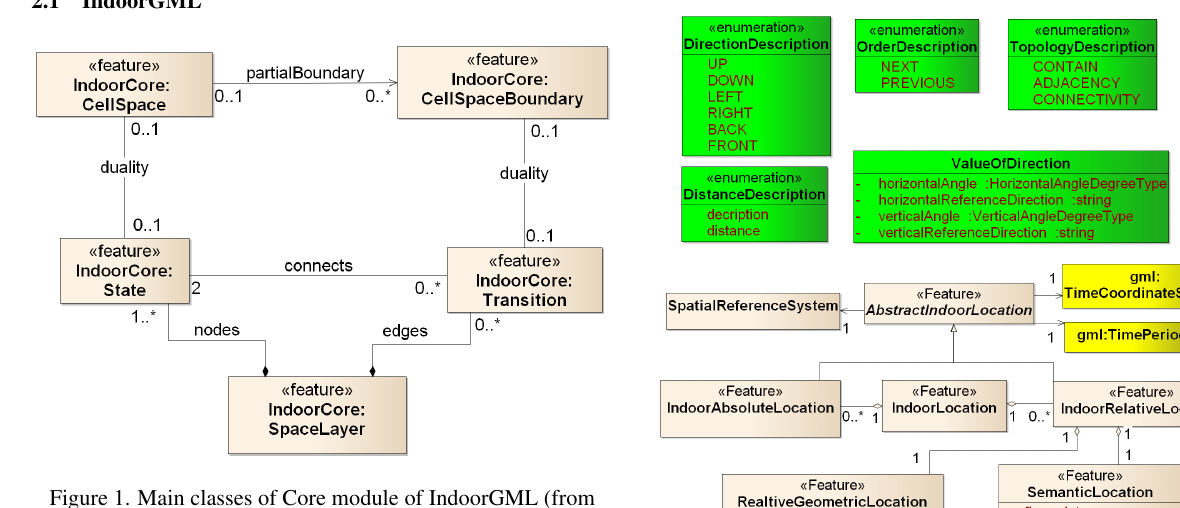
Figure 1. Main classes of Core module of IndoorGML (from Lee et al., 2014)